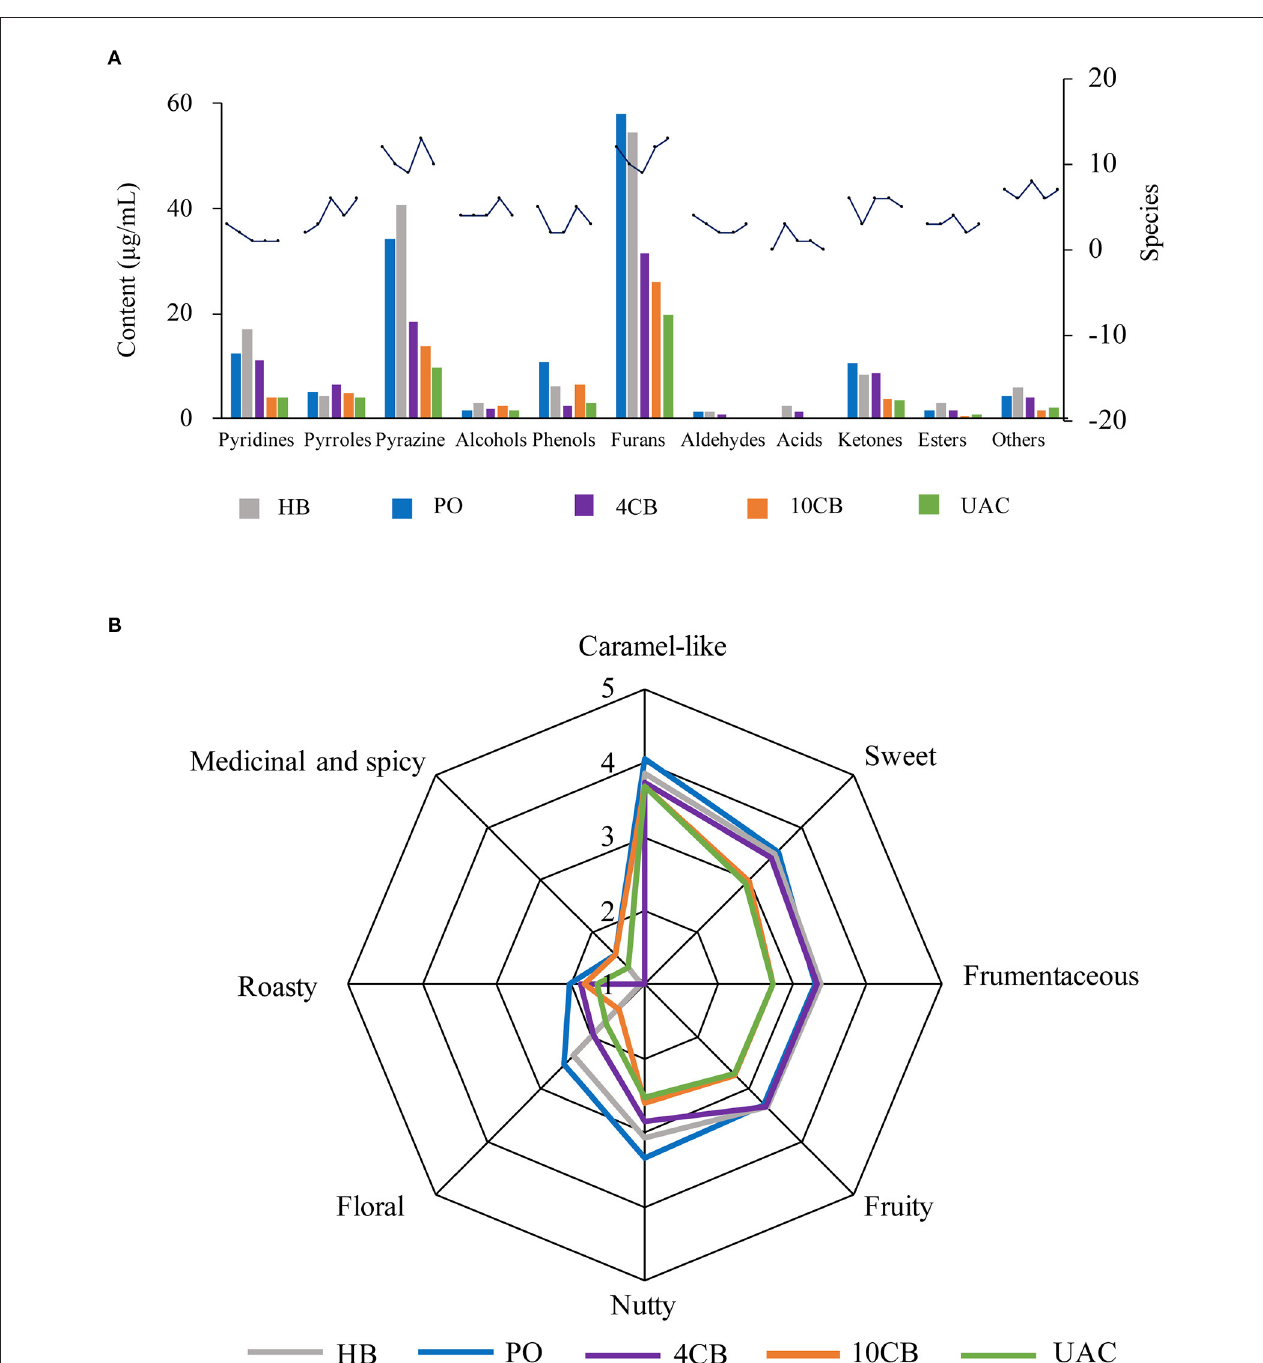
FIGURE 3 | Contents and species of volatile compounds (A) and spider plots of aroma attributes (B) for different coffee brewing methods. HB, Hot boiled, PO, Pour-over, 4 CB, 4 ◦ C cold brew, 10 CB, 10 ◦ C cold brew, UAC, Ultrasound-assisted cold